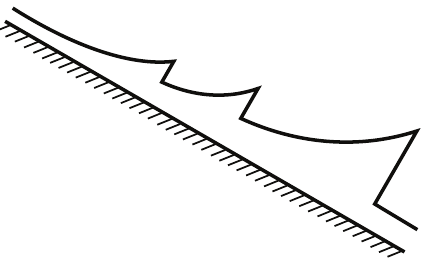
Figure 5. A possible shape of an avalanche under conditions of